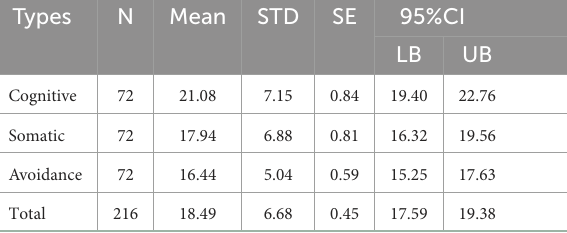
TABLE 5 Descriptive results through one way ANOVA analysis.